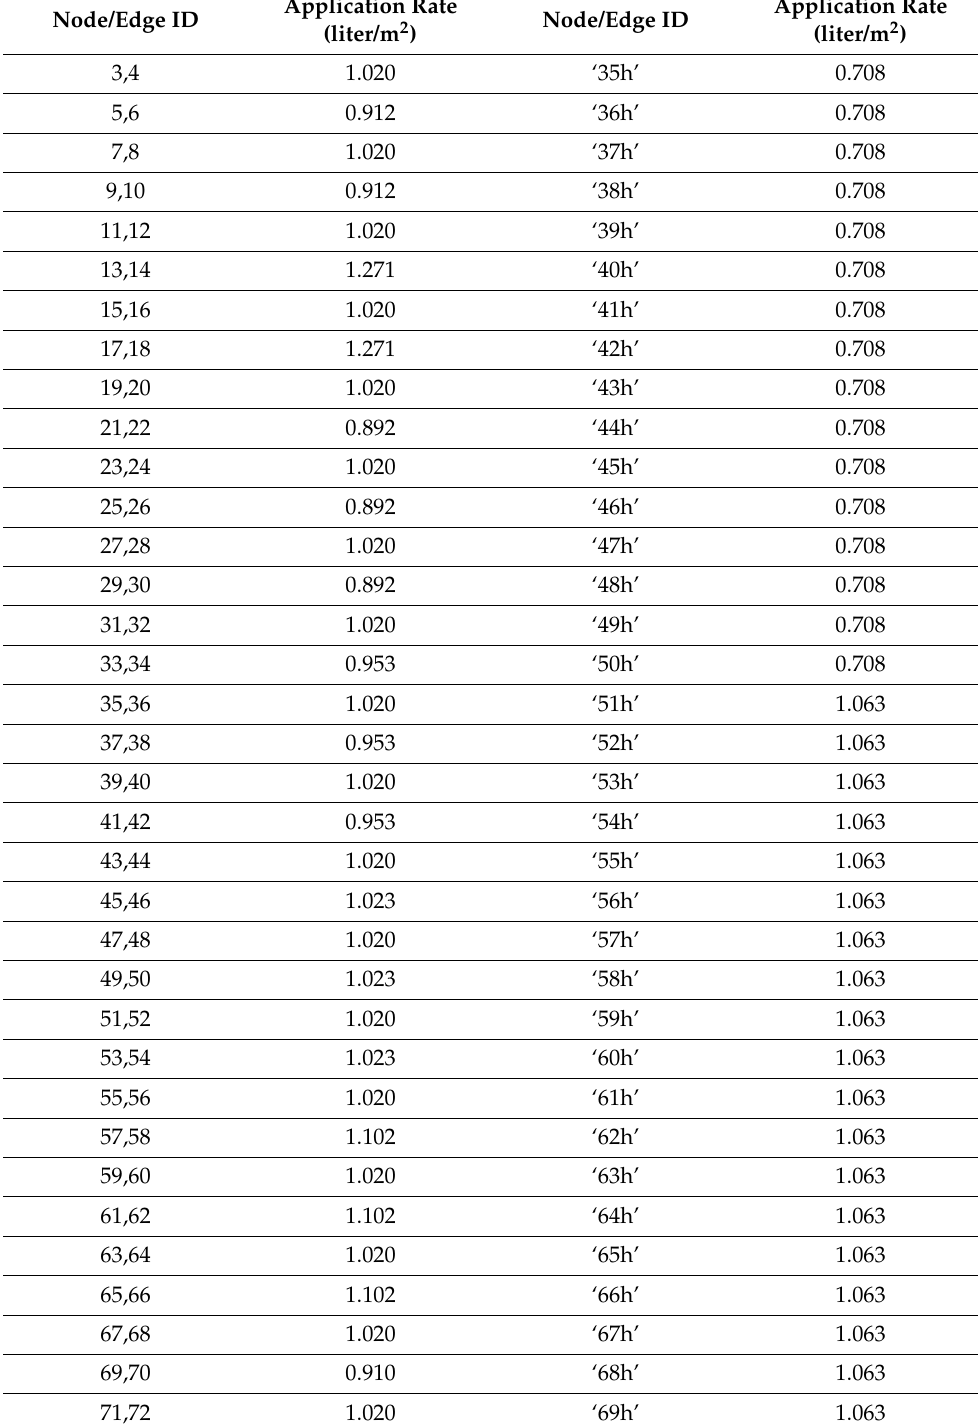
Table A2. The list of application rates for covering the sample field with a homogeneous fleet of robots (capacity 0.8 m 3